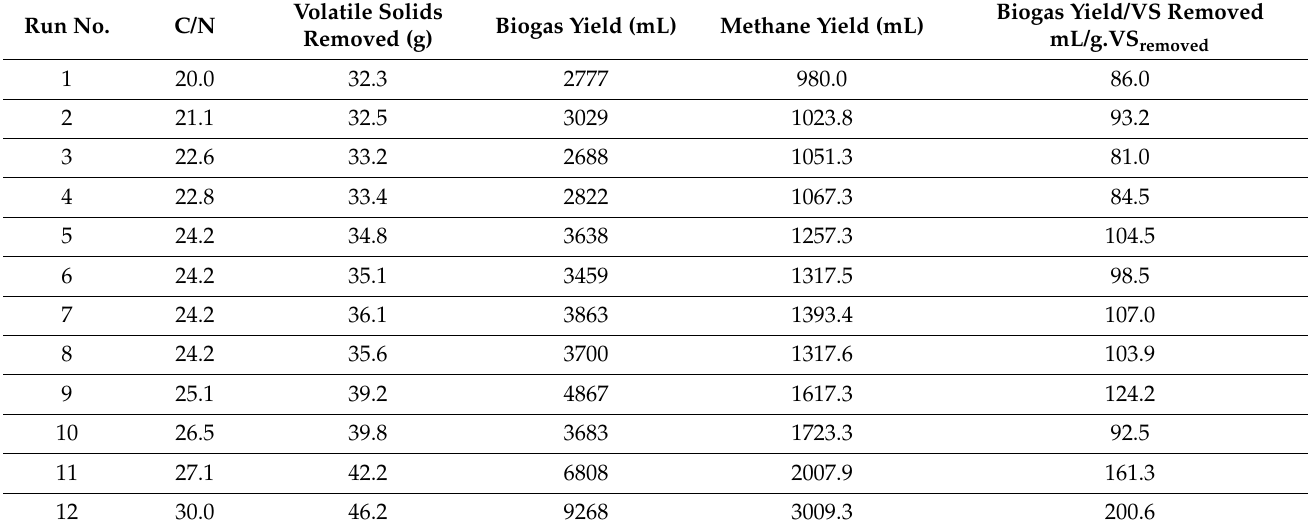
Table 6. Biogas yield and methane content vs. carbon/nitrogen and co-substrate VS/inoculum VS ratios. Run